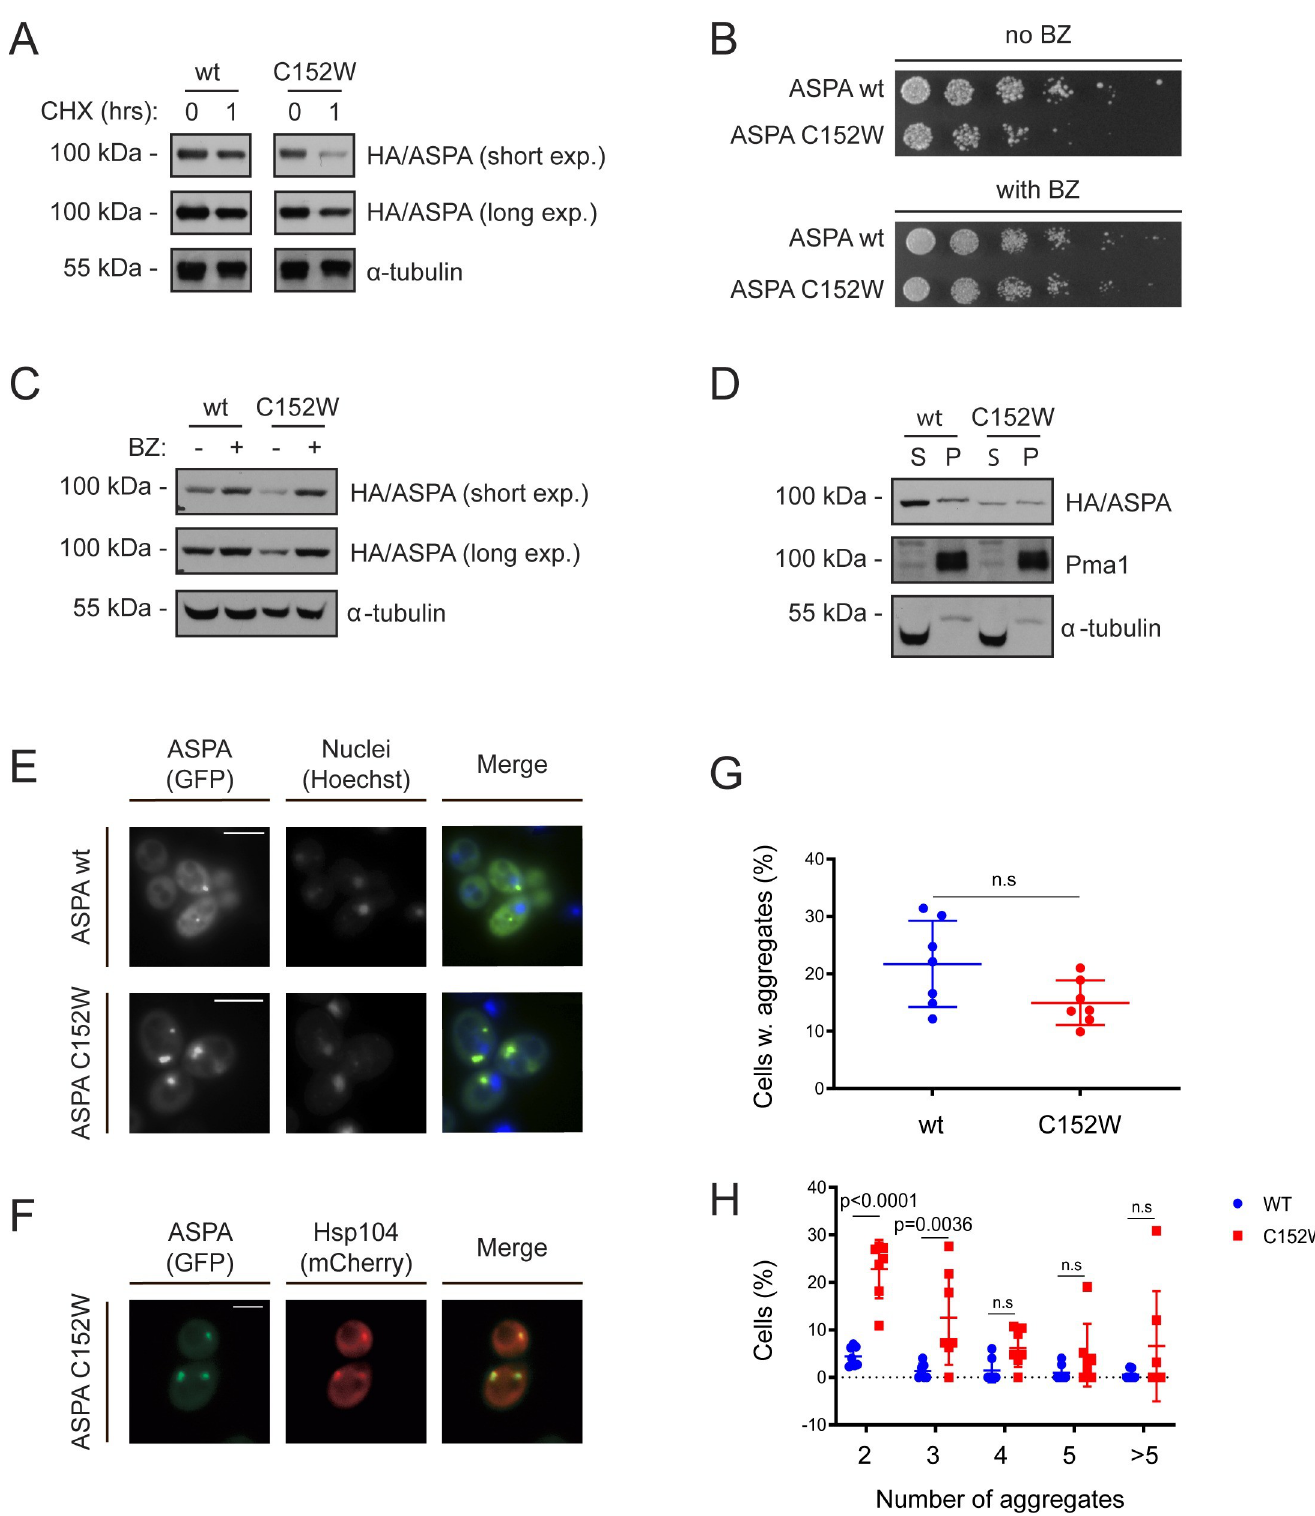
Fig 2. The ASPA C152W variant is an unstable proteasome target which forms multiple aggregates. (A) Western blot of ASPA protein levels in wild-type yeast expressing the indicated ASPA variant and treated with the translation inhibitor cycloheximide (CHX) for 1 hour (1) or, as a control, with the solvent DMSO (0). Yeast cells were cultured with 0.1 mM CuSO 4 . Blotting for α -tubulin was included as a loading control. (B) Growth of wild-type yeast cells expressing the indicated ASPA construct on solid medium without uracil either in absence (no BZ) or in presence (with BZ) of the proteasome inhibitor bortezomib (BZ). (C) Western blot of ASPA protein levels in wild-type yeast expressing the indicated ASPA variant in presence of 0.1 mM CuSO 4 and treated with DMSO (-) or bortezomib (BZ, +) for